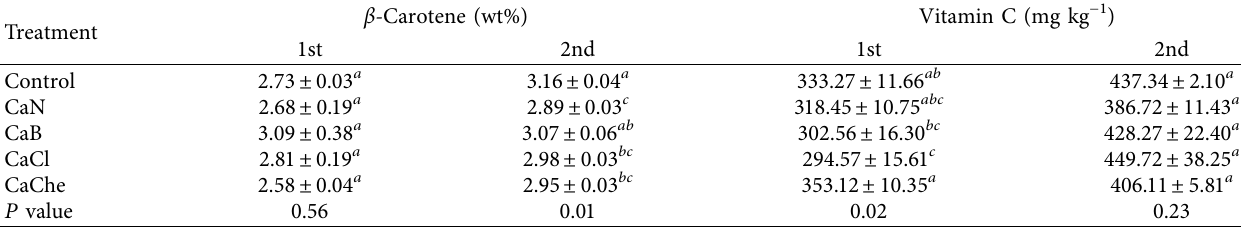
Table 6: Effect of calcium on β -carotene and vitamin C of pineapple fruit.